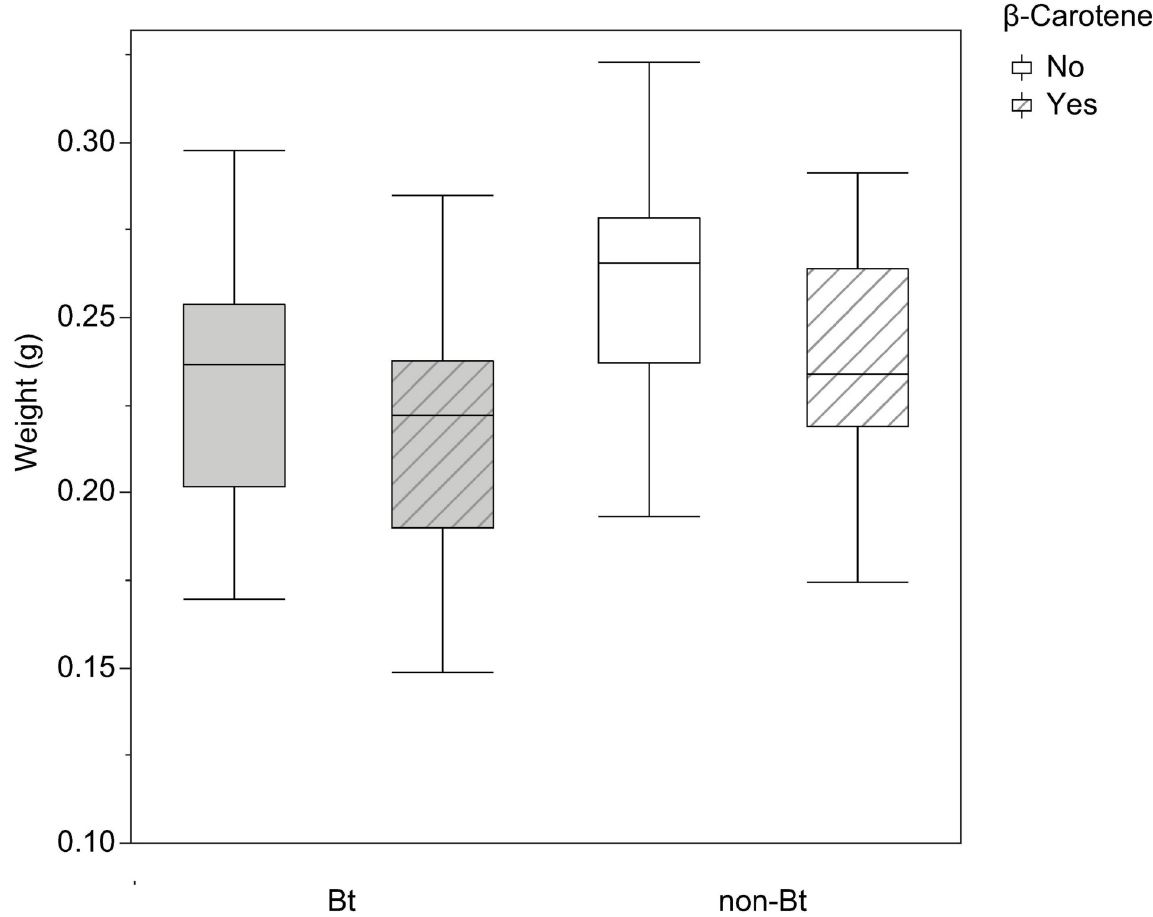
Fig 3. Weight of Helicoverpa armigera F1 pupae. Effect of the addition of vitamin A ( β -carotene: 0 or 0.6% in weight) to non-Bt or Bt diets on the weight of the resulting F1 pupae of Helicoverpa armigera . Bt (grey boxplot) indicates diets prepared with lyophilized leaves of Bt maize while non-Bt (white boxplot) indicates diets prepared with lyophilized leaves of non-Bt maize. Lined boxplots represent the addition of β -carotene to the diets while plots without lines represent diets without β -carotene. Statistical test: Two-way ANOVA ( P < 0.005), means were compared by the LS Means Student’s test.